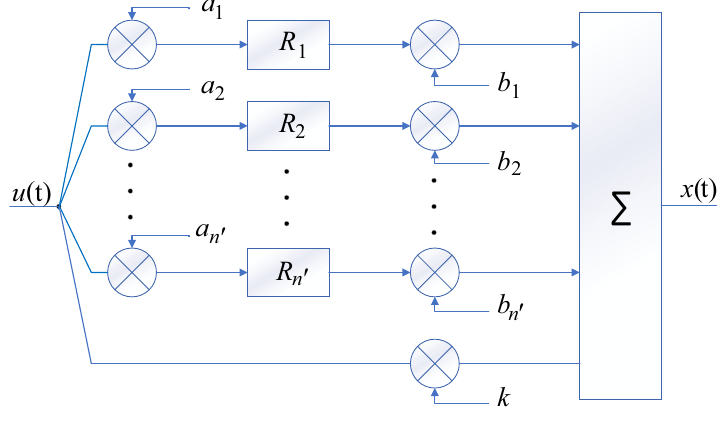
Figure 4. The scheme of the Preisach converter.